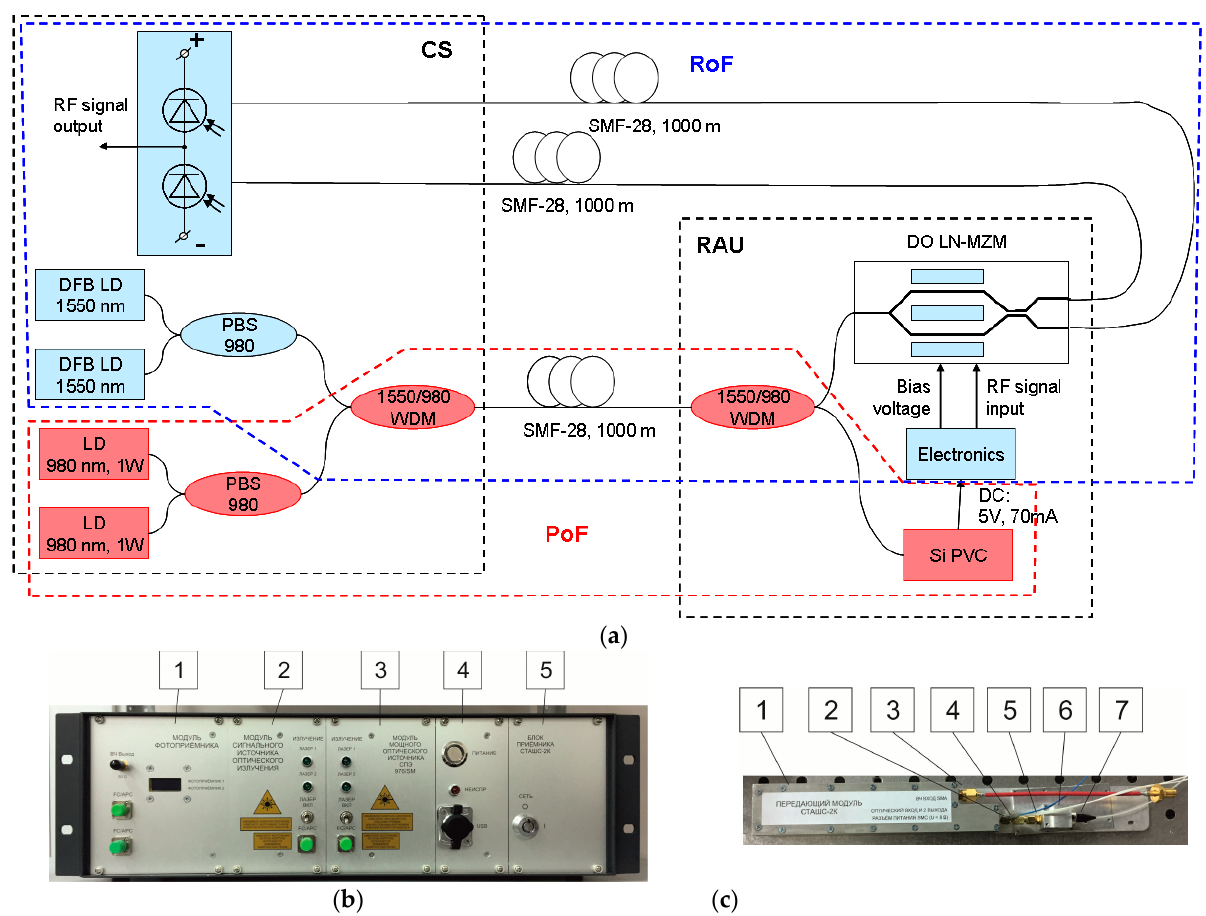
Figure 1. ( a ) Schematic diagram of the proposed system based on the RoF technology with opti ‐ cally powered RAU. ( b ) Central station (CS) layout: 1—balanced photodetector,